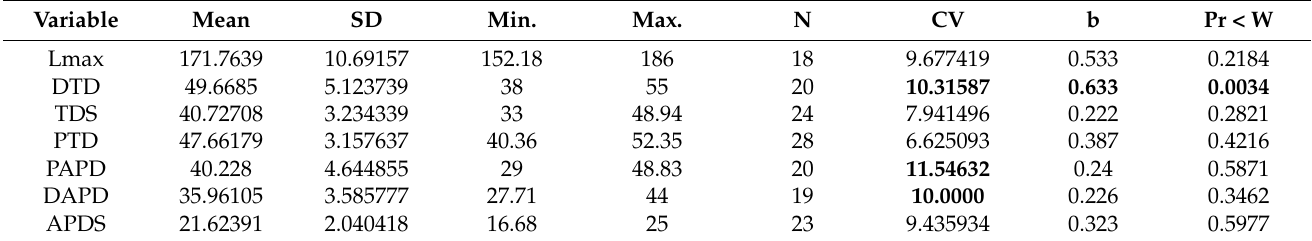
Table 5. Sex-combined statistics for third metatarsal variables.